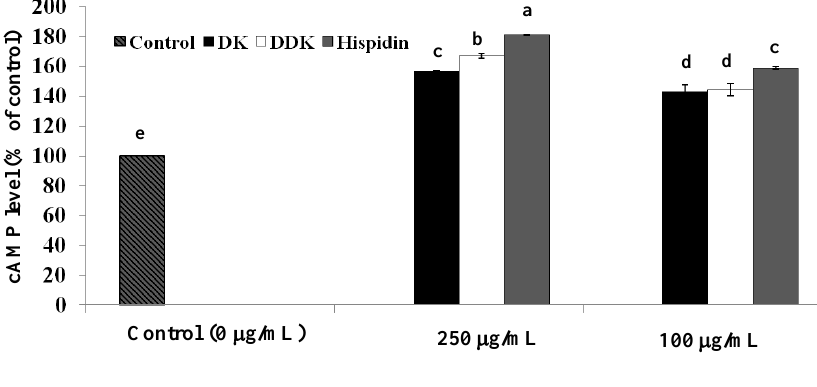
Figure 5. The effect of hispidin, DK and DDK on intracellular cAMP concentrations